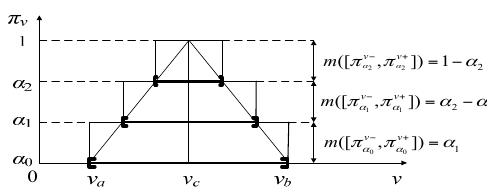
Figure 4. The possibility distribution of state noise and its evidence construction.